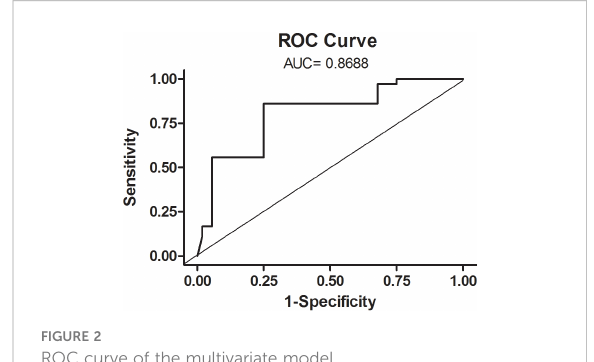
FIGURE 2 ROC curve of the multivariate